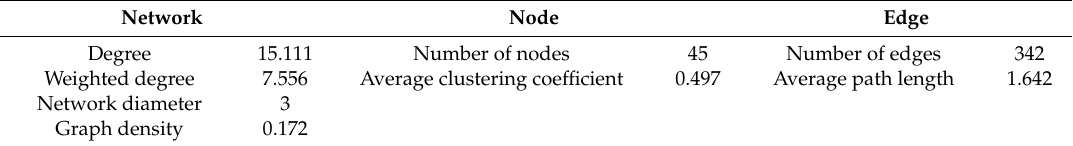
Table 3. The network indexes of the spatial network of IFMA ij